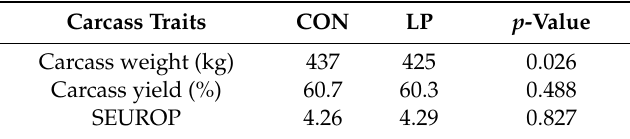
Table 5. The e ff ects of high protein (CON) and low protein (LP) diets on carcass weight, carcass yield and SEUROP-carcass classification.